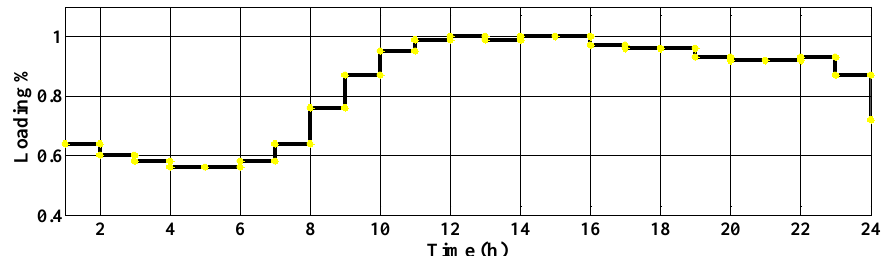
Figure 3. The hourly load profiles.